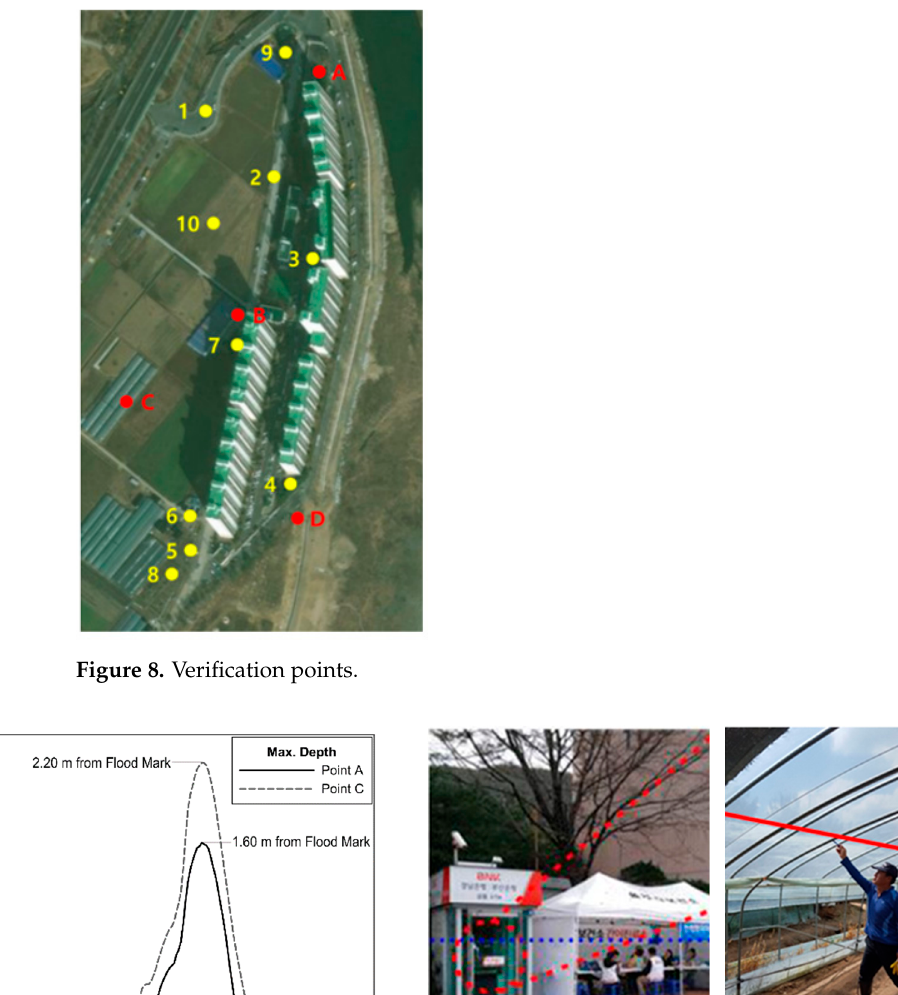
Figure 7. Comparison of inundation area near apartments [35].